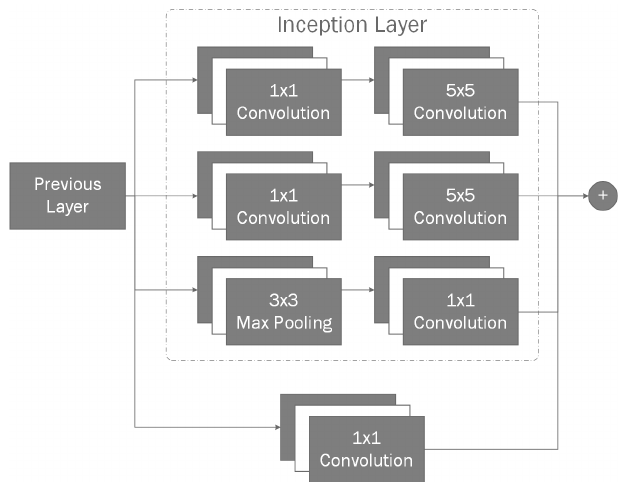
Figure 6. An example of the inception layer. An input layer is connected to three branches in parallel. If multiple inception layers are used inception layers are connected sequentially. Final inception layer outputs and 1 × 1 convolution are then connected using addition. The result is then used for subsequent layers.